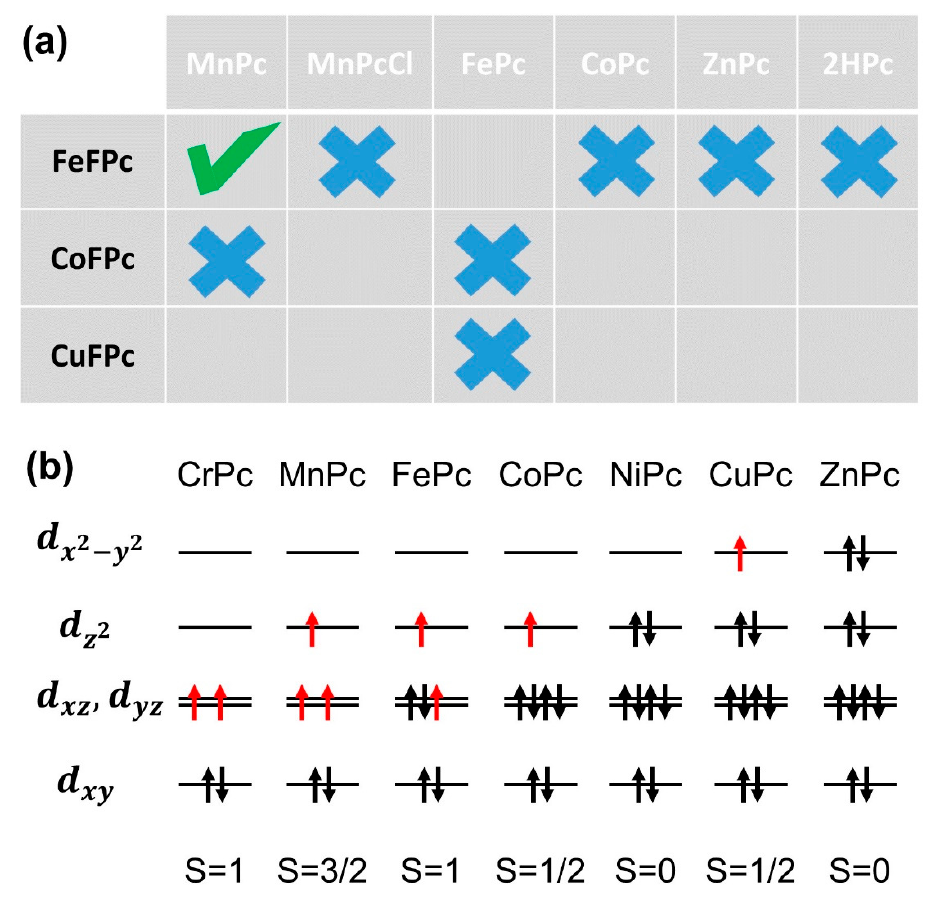
Figure 3. Overview of the investigated binary assemblies and electronic structures of individual phthalocyanine molecules. ( a ) Tabular representation of the investigated binary systems and summary of our extensive XAS/XMCD investigations: at 2.5 K, magnetic remanence of the 2D spin-checkerboard was observed exclusively for MnPc and FeFPc. ( b ) Electron filling scheme for the different MPcs: (black) indicates paired and (red) indicates un-paired electrons in D 4h symmetry. Below, the total spin due to the unpaired electrons has been listed. Note that this configuration is prone to change, as the molecules experience a modified ligand field (C 4v ), e.g., by their adsorption on the surface or by ligand interaction/coordination.